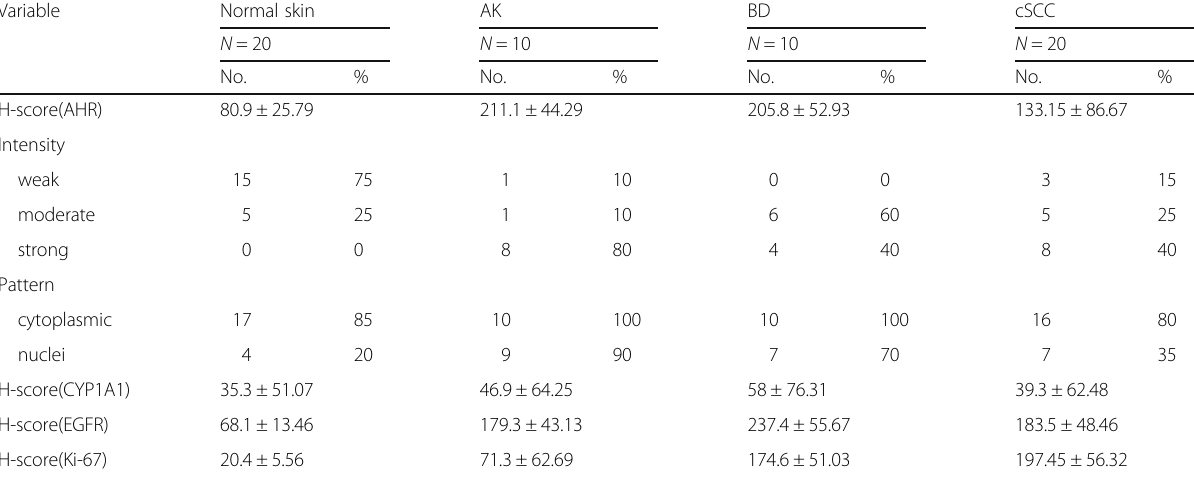
Table 3 Expression of AHR, CYP1A1, EGFR and Ki-67 in studied groups Variable Normal skin